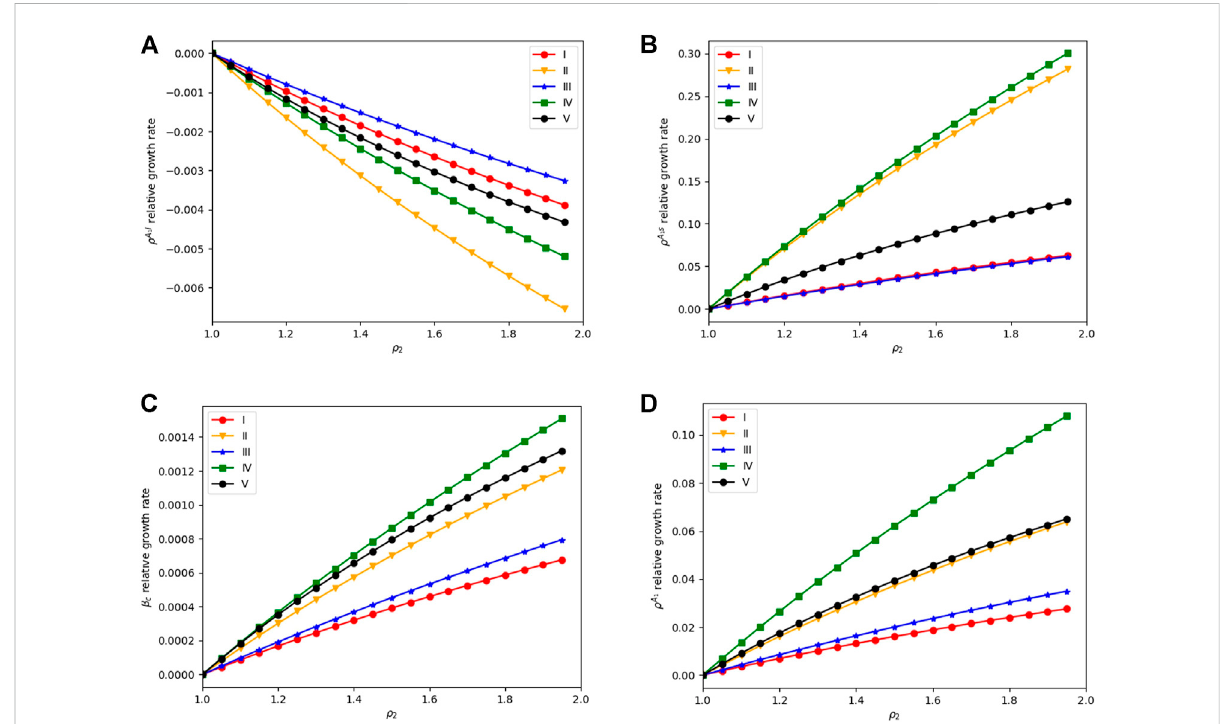
FIGURE 9 ρ ρ ρ 1 , 2 ,and 3 asfunctionsof with different parameter settings. (I)